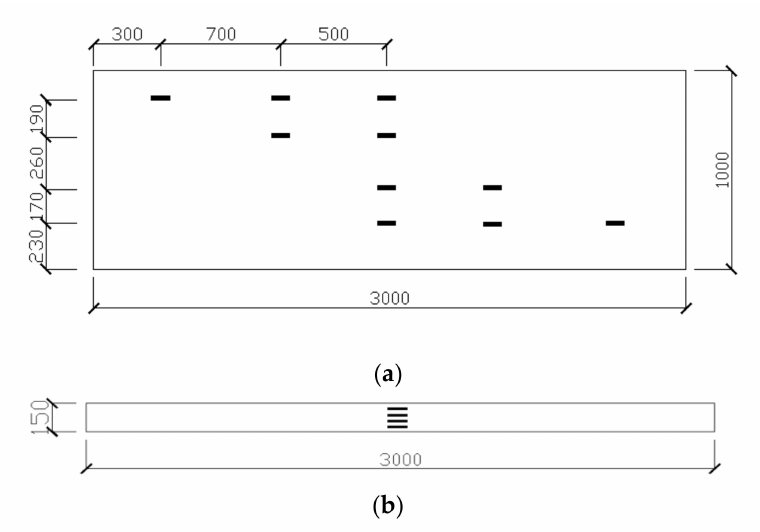
Figure 4. Schematic diagram of measuring points of foam concrete slab strain gauge. ( a ) Strain gauges at top and bottom surface of the foam concrete slab; ( b ) Strain gauges at the long edge of the foam concrete